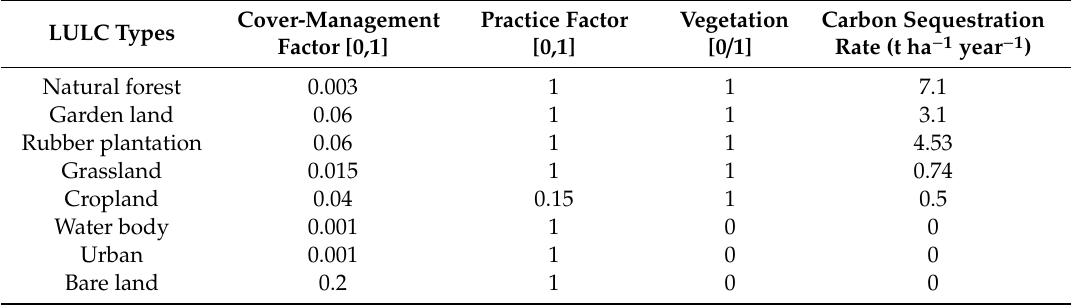
Table 4. Biophysical coe ffi cients for sediment delivery ratio (SDR) module in InVEST and carbon sequestration